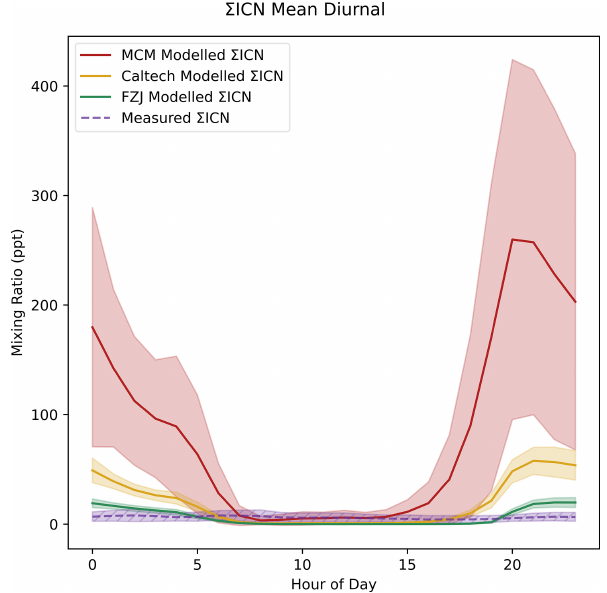
Figure 12. Measured and modelled (cid:54) ICN. Each line shows the mean value for each dataset, with the shaded area indicating 1 stan- dard deviation above and below the